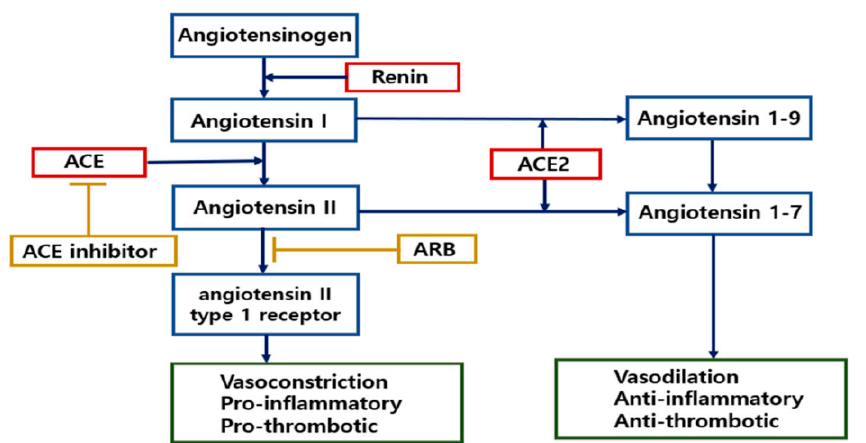
Figure 3. Role of ACE and ACE2 in modulating blood pressure in the renin–angiotensin system (RAS). The renin-angiotensin system (RAS) is an essential hormone system that regulates blood pressure and fluid balance in the body. Renin converts angiotensin to angiotensin I and then ACE converts angiotensin I to angiotensin II. Angiotensin stimulates production of cytokines and exerts proinflammatory, prothrombotic, and vasoconstrictive effects. ACE2 converts angiotensin II to angiotensin 1-7 and exerts opposing effects. Most common antihypertensive drugs are ACE inhibitors and angiotensin II receptor blockers (ARBs) and lower blood pressure by blocking angiotensin II related signaling